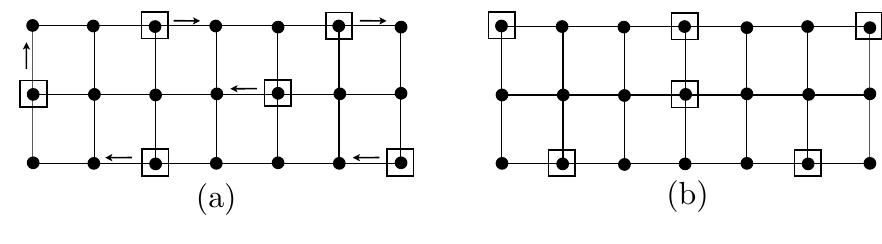
Figure 8: A total-switch for P